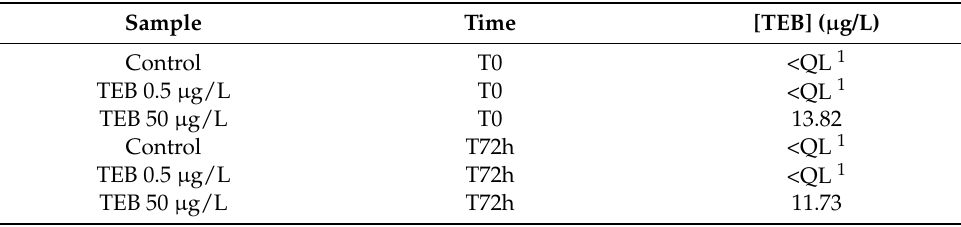
Table 1. Concentration of tebufenozide (TEB) in